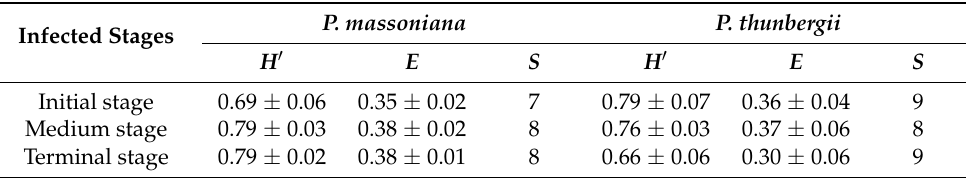
Table 3. Community characteristic indexes of xylophagous beetles in P. massoniana and P. thunbergii at different infection